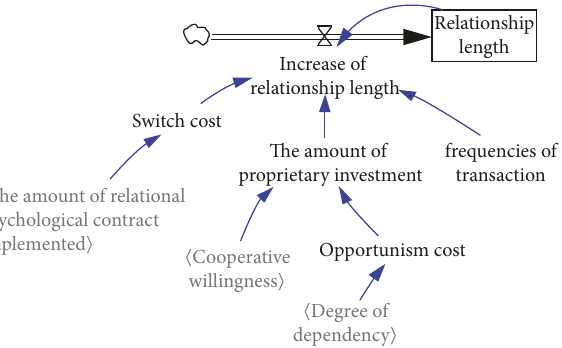
Figure 4: Changes of relationship justice (CRJ) rate variable in-tree